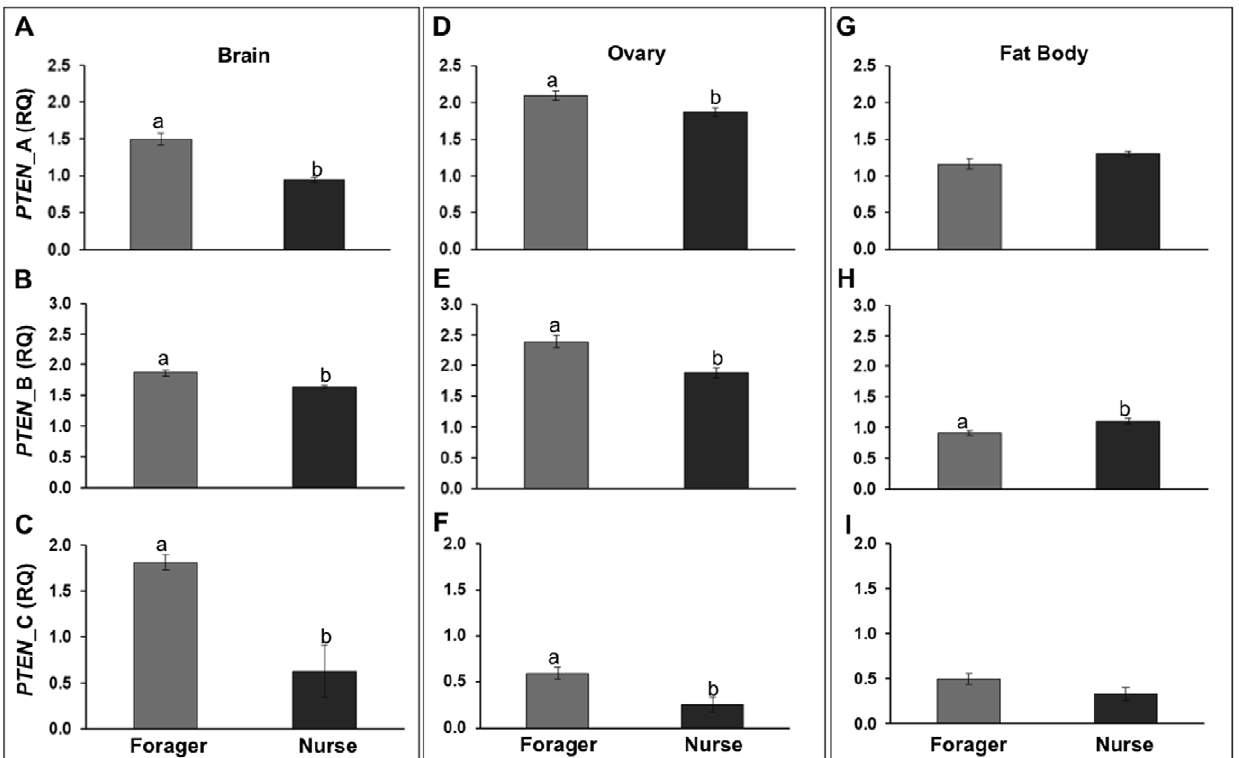
Figure 4. PTEN isoform- and tissue-specific expression in adult forager and nurse bees of the same chronological age. RT-qPCR was used to determine isoform-specific PTEN transcript levels in (A–C) Brain; (D–F) Ovary; and (G–I) Fat body. Age matched (20-day old bees) nurses and foragers from single-cohort colonies were used for the expression analysis. All RT-qPCR samples were run in triplicate. Brain, ovaries and fat body from 3 individual bees were pooled by tissue to make up one biological sample (n=6). Bars represent mean 6 s.e, different letters (a, b) indicate significant differences as determined with a Fisher LSD post-hoc test, p , 0.05.